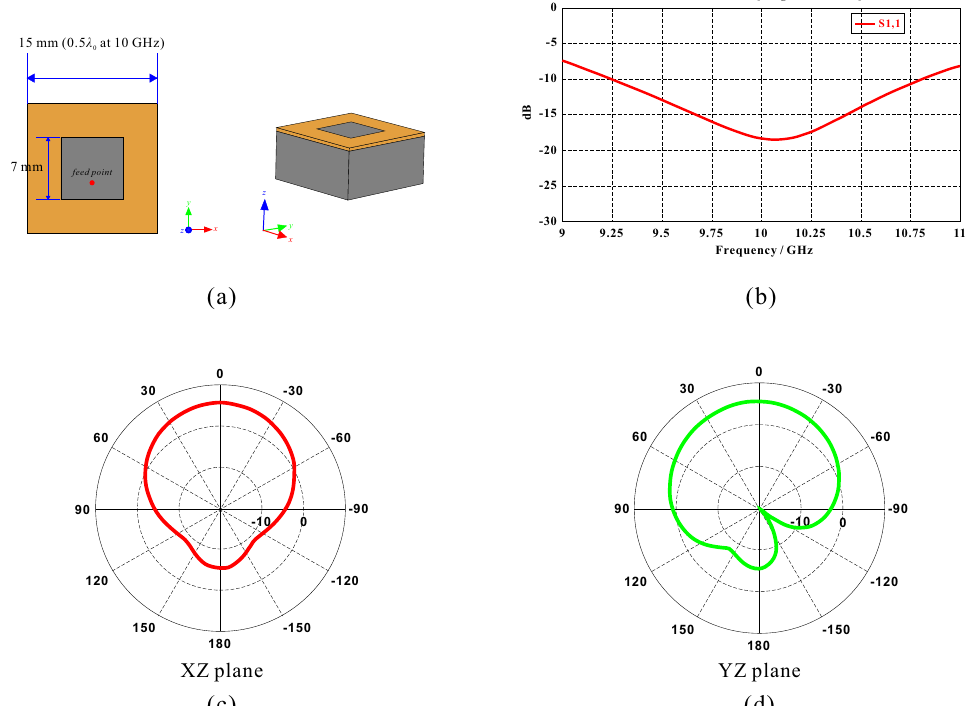
Figure 6. Cavity-backed patch antenna: ( a ) element shape, ( b ) S-parameters, ( c ) φ = 0 ◦ radiation pattern and ( d ) φ = 90 ◦ radiation